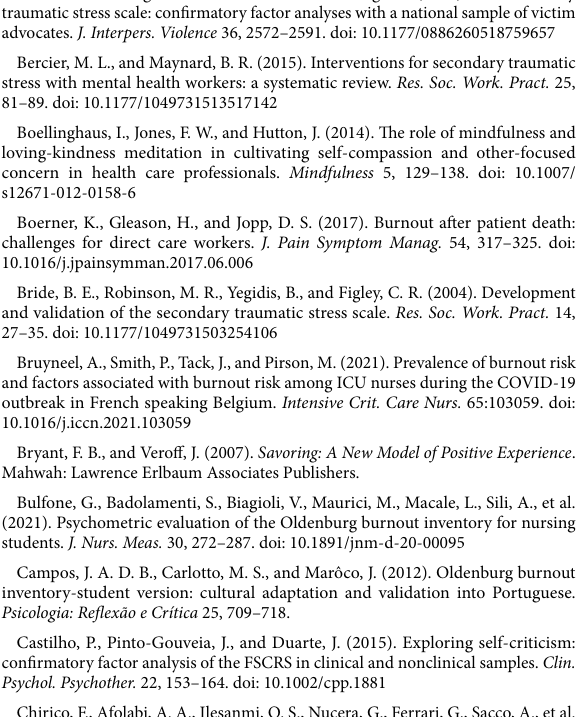
Figley, C. R. (1995a). “Compassion fatigue as secondary traumatic stress disorder: an overview” in Compassion Fatigue: Coping with Secondary Traumatic Stress Disorder in Those Who Treat the Traumatized . ed. C. Figley (New York, NY: Routledge), 1–20. Figley, C. R. (1995b). “Compassion fatigue: toward a new understanding of the costs of caring” in Secondary Traumatic Stress: Self-Care Issues for Clinicians, Researchers, and Educators . ed. B. H. Stamm (Lutherville, MD: The Sidran Press), 3–28. Figley, C. R. (2002). Compassion fatigue: Psychotherapists' chronic lack of self care. J. Clin. Psychol. 58, 1433–1441. doi: